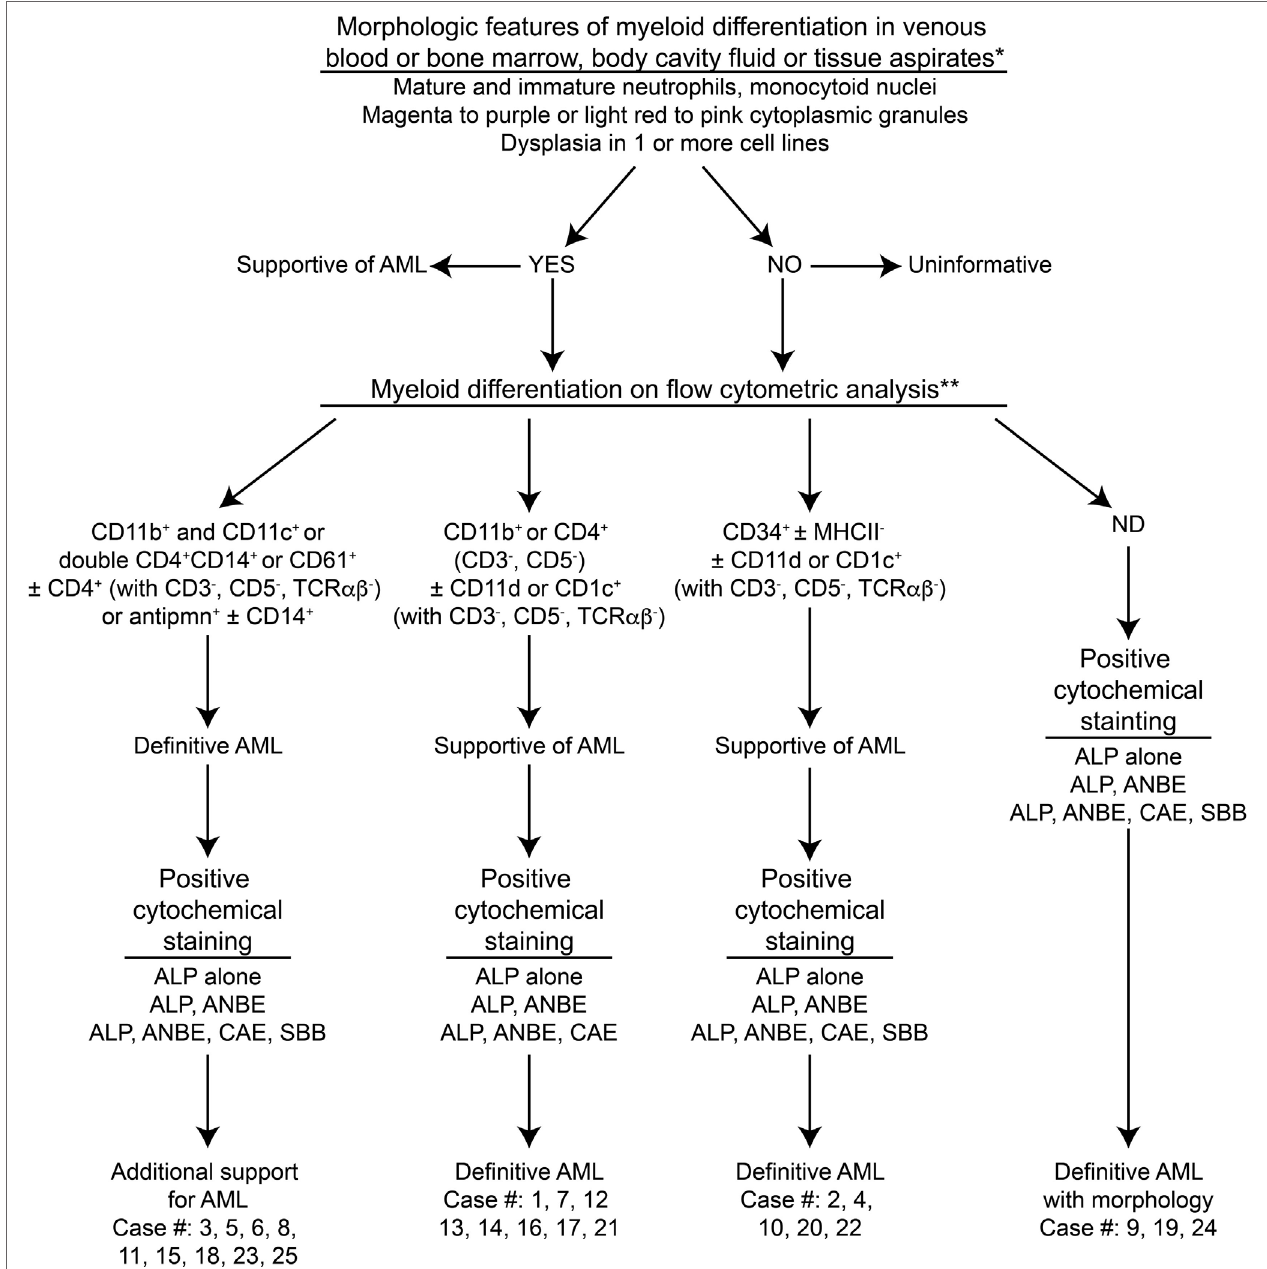
FigUre 1 | algorithm used to diagnose acute myeloid leukemia (aMl) in the 25 dogs of this study . This diagnostic algorithm was based on the order in which tests were generally performed in our laboratory, i.e., morphologic assessment of blood, bone marrow, or body cavity fluid or tissue aspirates, followed by flow cytometric analysis (performed routinely twice a week), followed by cytochemical staining (performed as needed). After completion of all the tests, the results were reevaluated, and a diagnosis of AML was based on the combined data. The path used to diagnose each case (#) is also shown. More details on the criteria are provided in Table 1